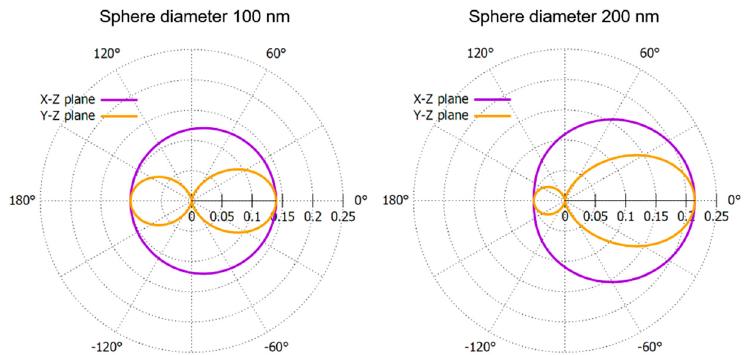
Figure 3. Polar graph of scattering patterns of spheres with diameters of 100 nm and 200 nm. Light is incident from the left on a sphere located at the center of the polar plot. The data are normalized so that the integral of it over 4 π steradians is unity.